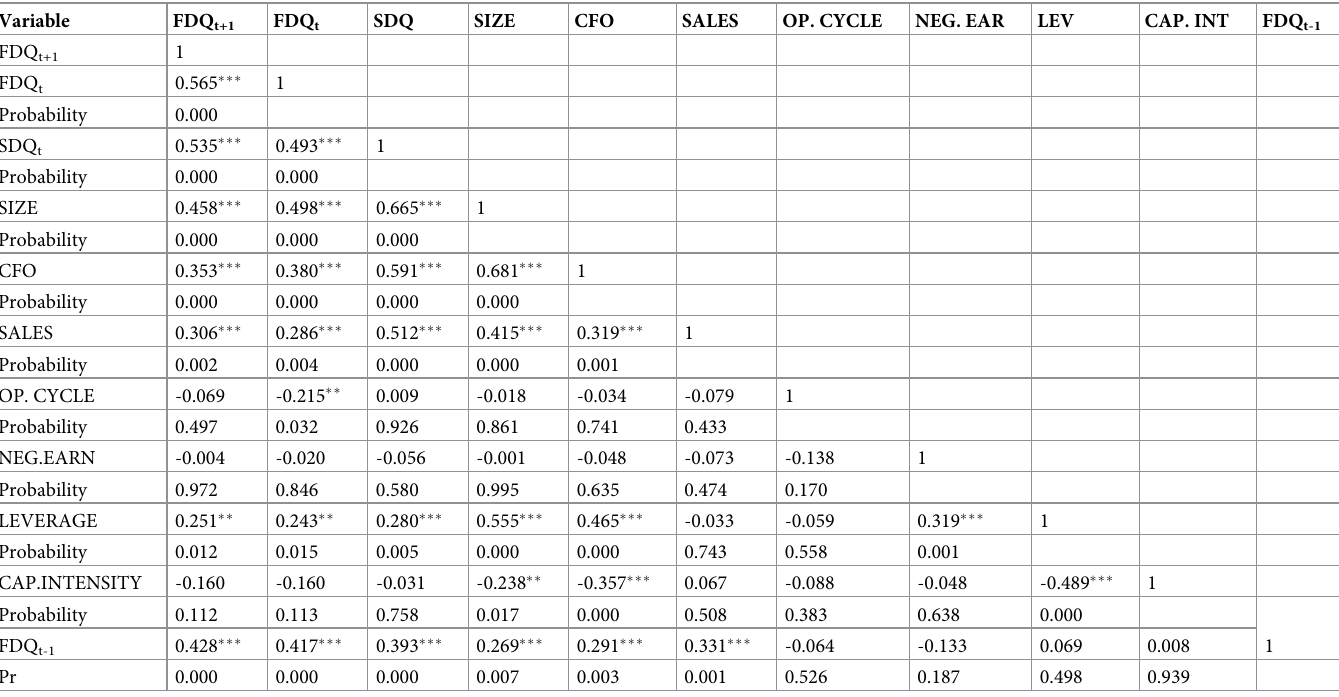
Table 3. Correlation matrix of the FDQ t and FDQ t+1 of the main model.